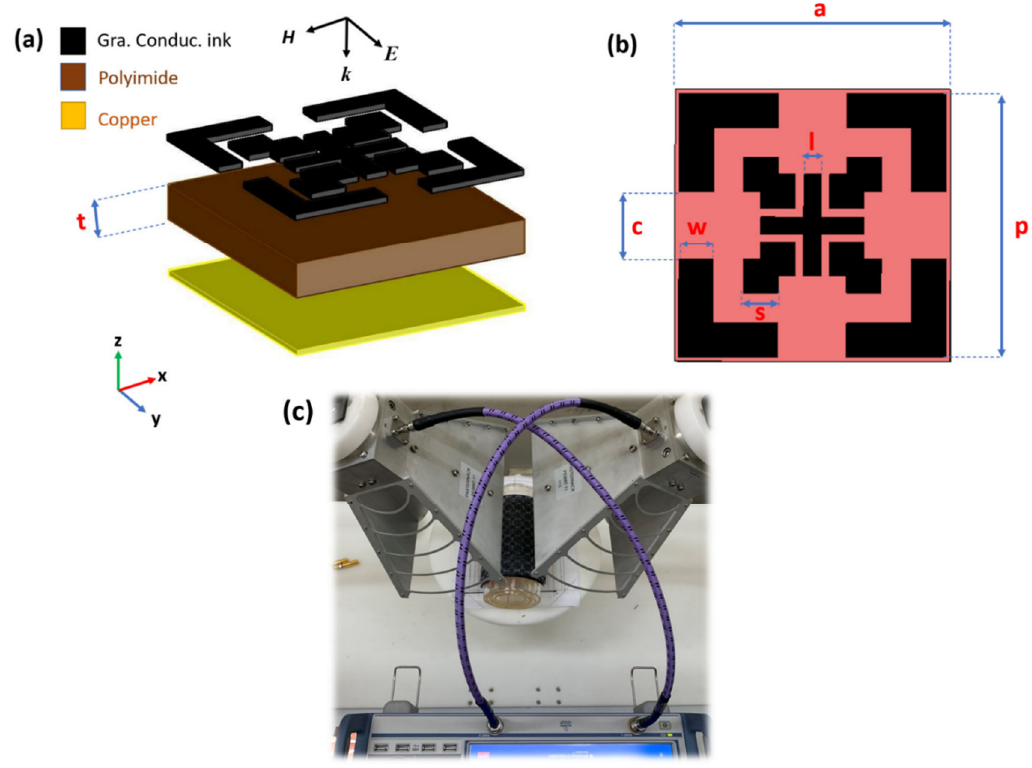
Figure 1. ( a ) Schematic of the three-dimensional unit cell and ( b ) the top view of FBMPA structure. ( c ) The measurement setup.